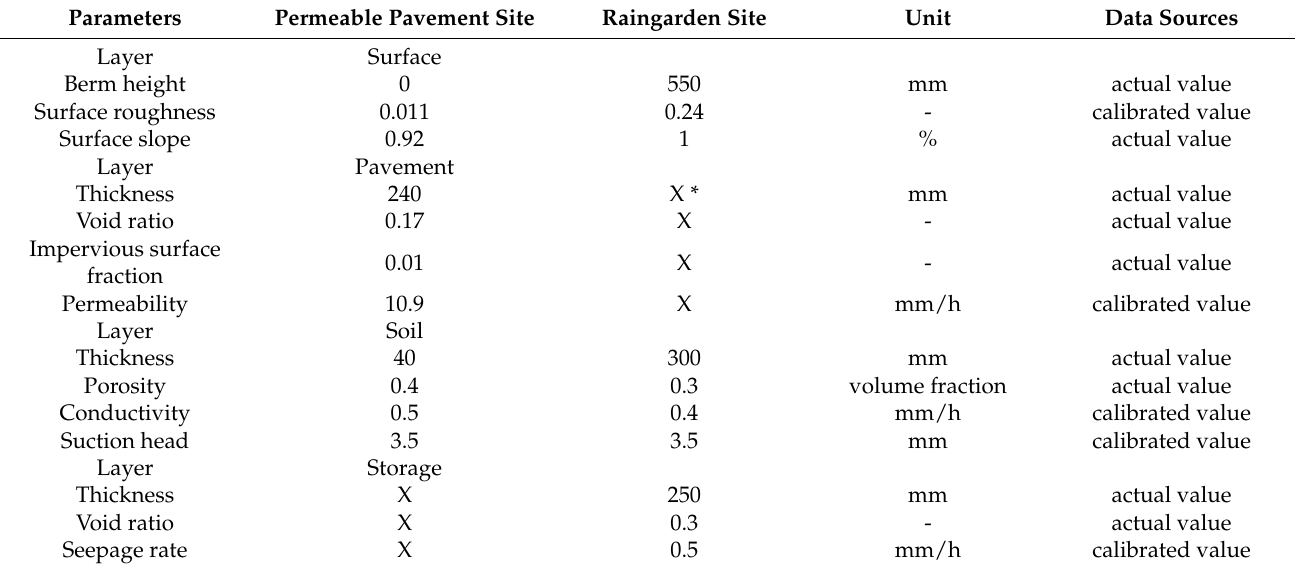
Table 3. The model parameters of the LID facilities used in the SWMM.